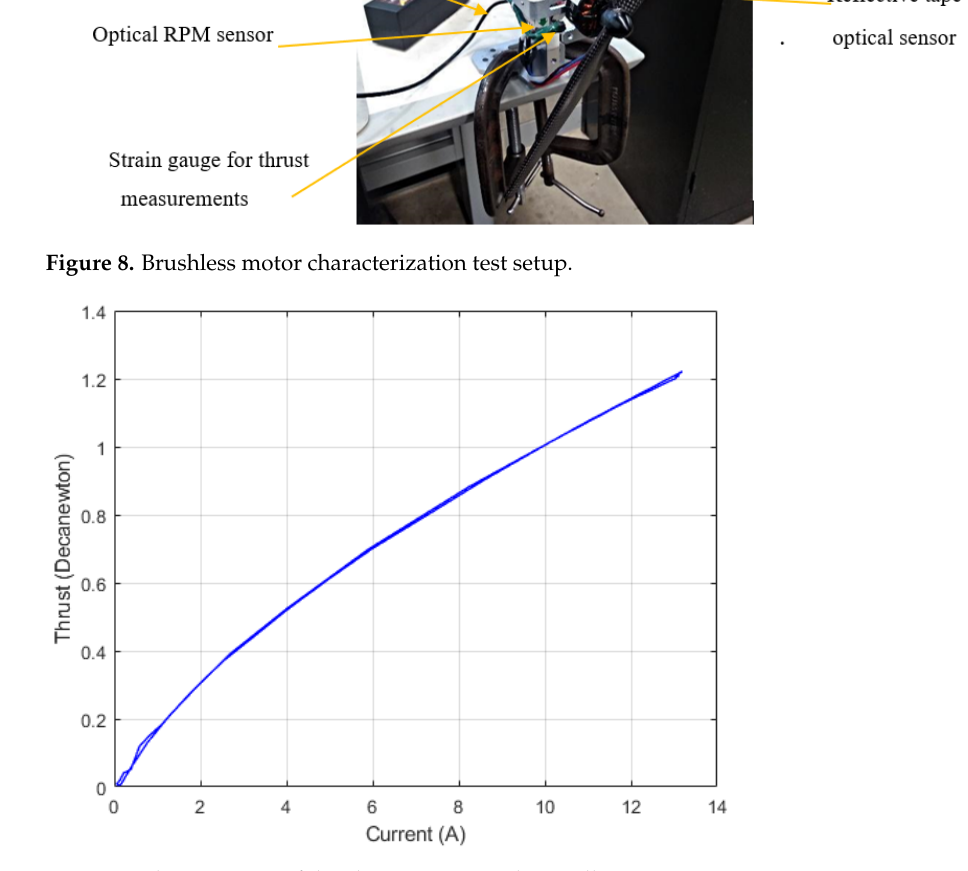
Figure 9. Thrust output of the electric motor and propeller across various current consumption